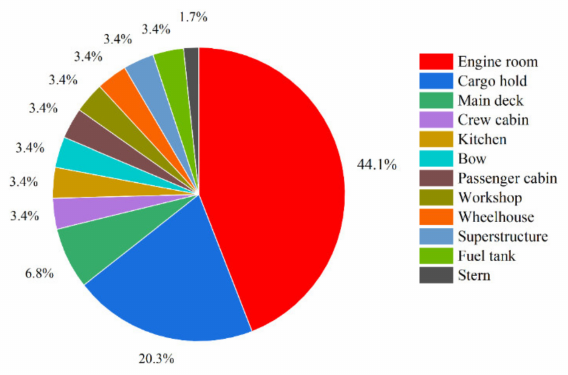
Figure 2. Statistical analysis of ship fire accidents’